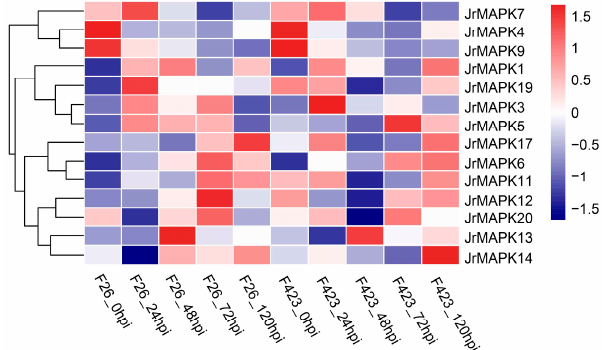
Figure 7. Transcriptional abundance of the JrMAPK genes in Colletotrichum gloeosporioides infections. Colored bars indicate normalized FPKM values, with red indicating high levels of expression, white no expression, and dark blue low expression. The detailed FPKM values are shown in Table S1.